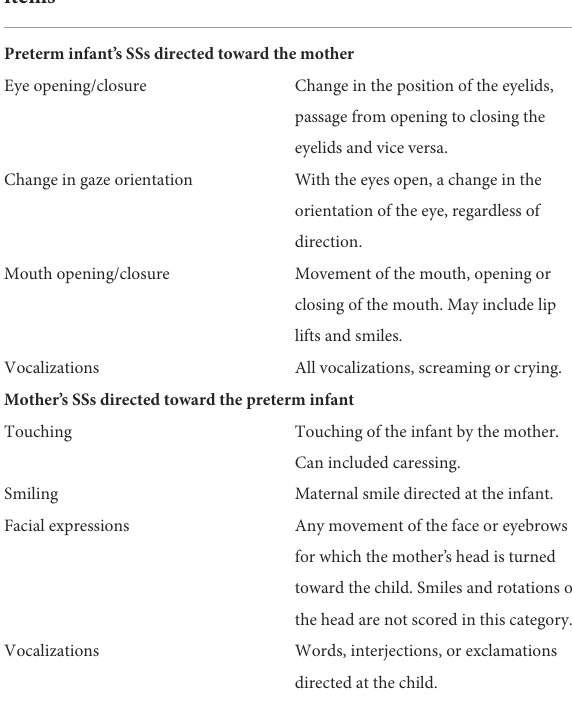
TABLE 1 List of social signals (SSs) included in the Preterm Infant Coding System for Maternal Sensitivity (PRICOSMAS). Social signal